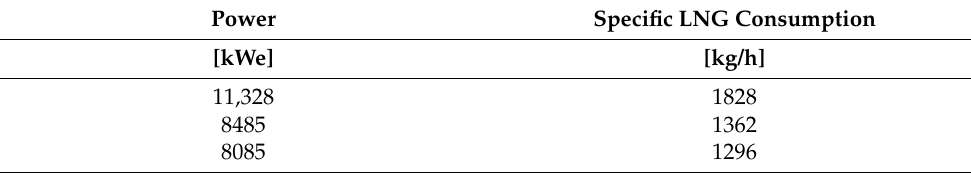
Table 5. Specific LNG consumption of the